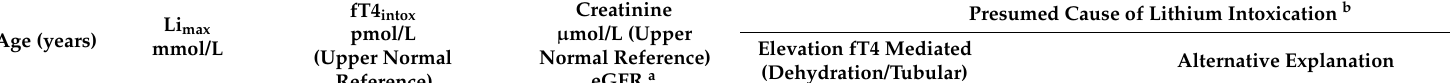
Table 4. Published cases reporting an association between elevated thyroxine concentrations and lithium